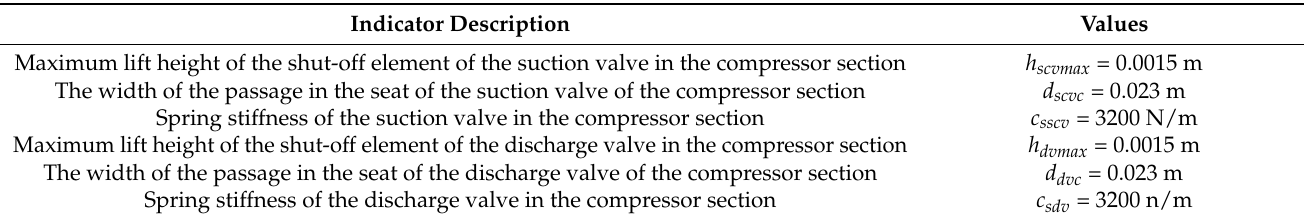
Table 2. Size dimensions of self-acting valves of stage 2 compressor section.